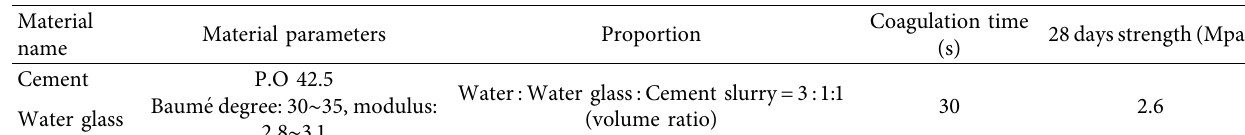
Table 3: Secondary grouting slurry ratio table.